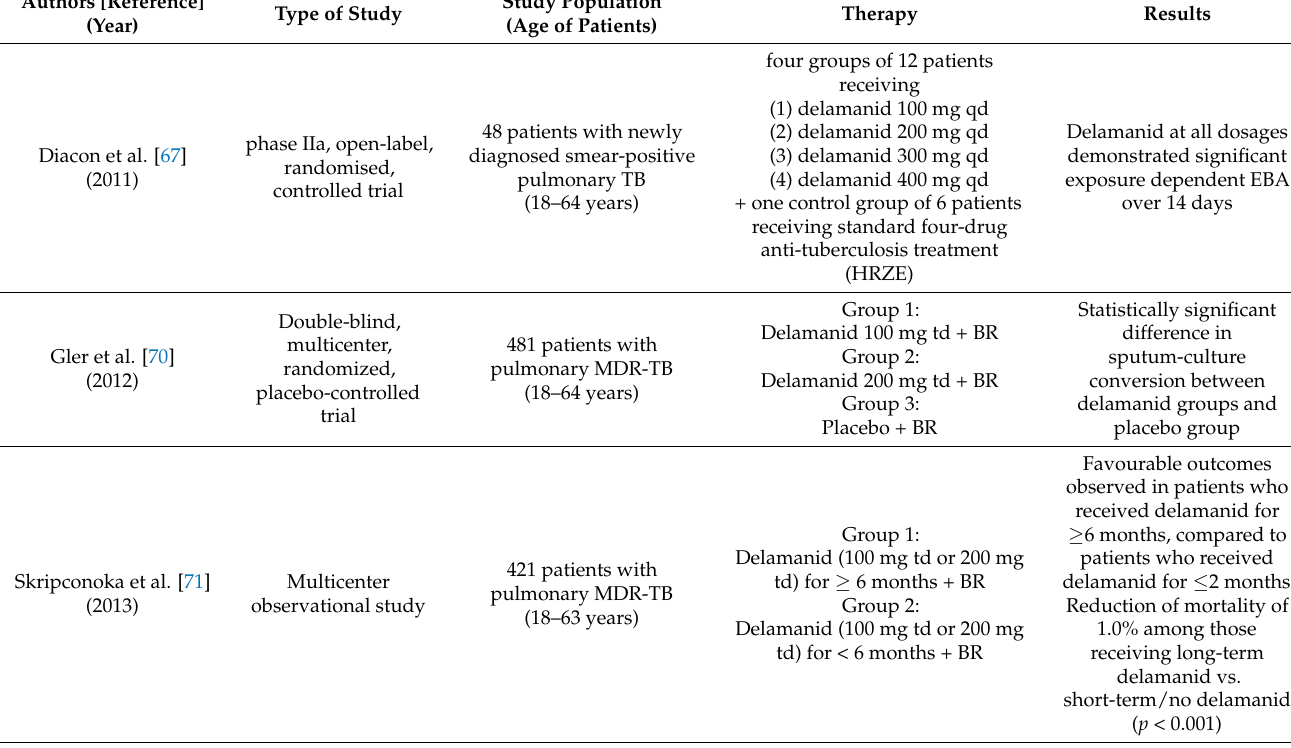
Table 6. Principal studies on the effectiveness of delamanid treatment in